Question: Draft a figure caption describing what is shown.
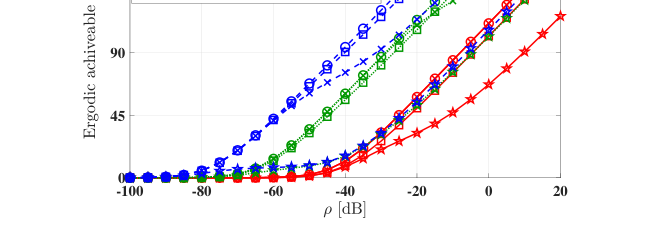
Answer: Simulation results of the ergodic achievable sum-rate R versus the transmit power ρ for different wavelength λ and different number of RHS elements N, with the number of UEs K = 8.